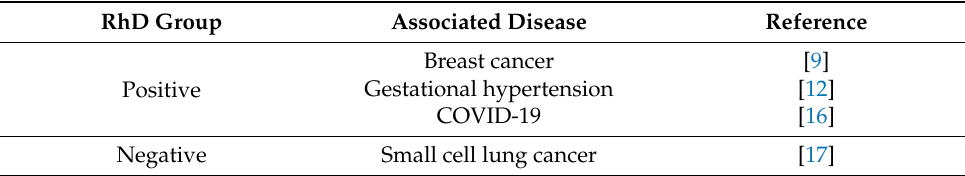
Table 2. Associations between the incidence of diseases with the blood groups of the RhD